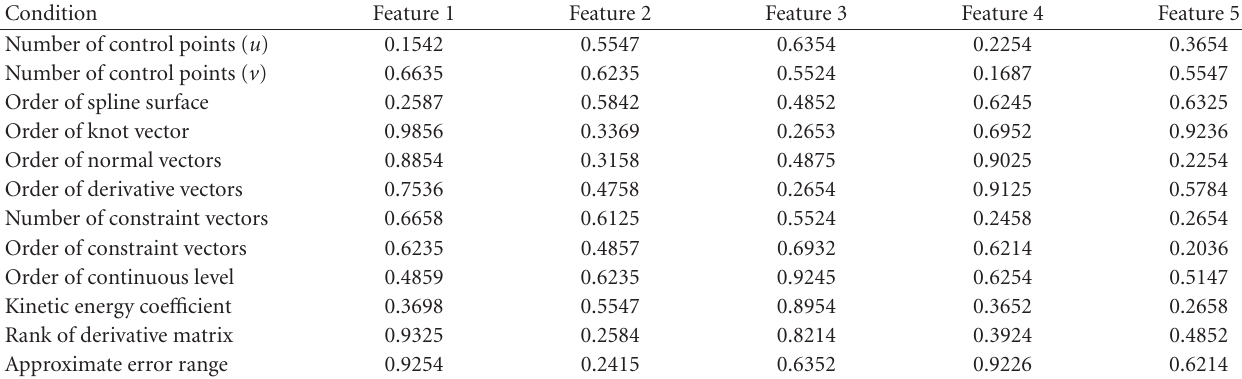
Table 9: Fuzzy relation degrees between experimental condition parameters and kinetic energy distribution surface features in the form of energy optimization modeling surface.